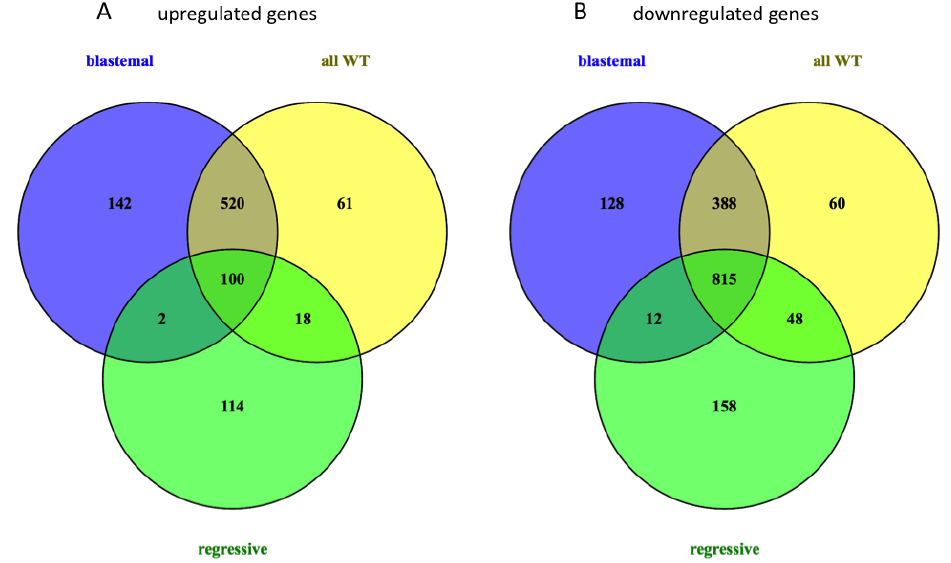
Table S2. In general, we found an increased number of miRNAs and mRNAs each downregulated in WTs as compared to the normal tissues, most notably in blastemal WTs vs. normal kidneys.